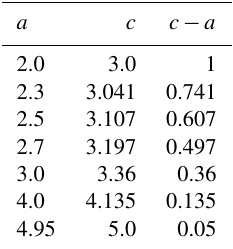
Table 1. This table shows for a sample of daily minimum AFs the distance relationship between the daily minimum AF of an observed point, a , and the scaling factor threshold, c , used in the modified objective function (Eq.